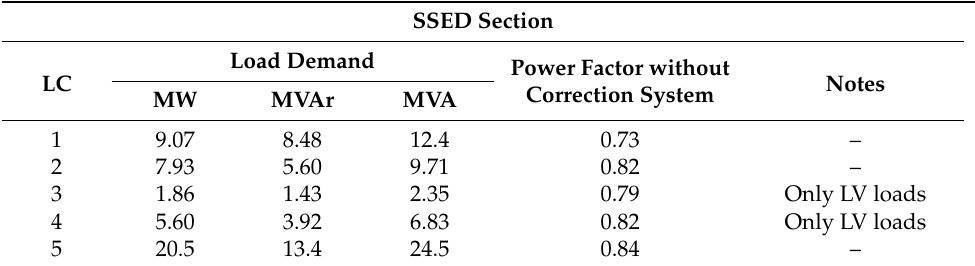
Table 2. Active, reactive and apparent power required by DTT distribution LCs, SSED section.